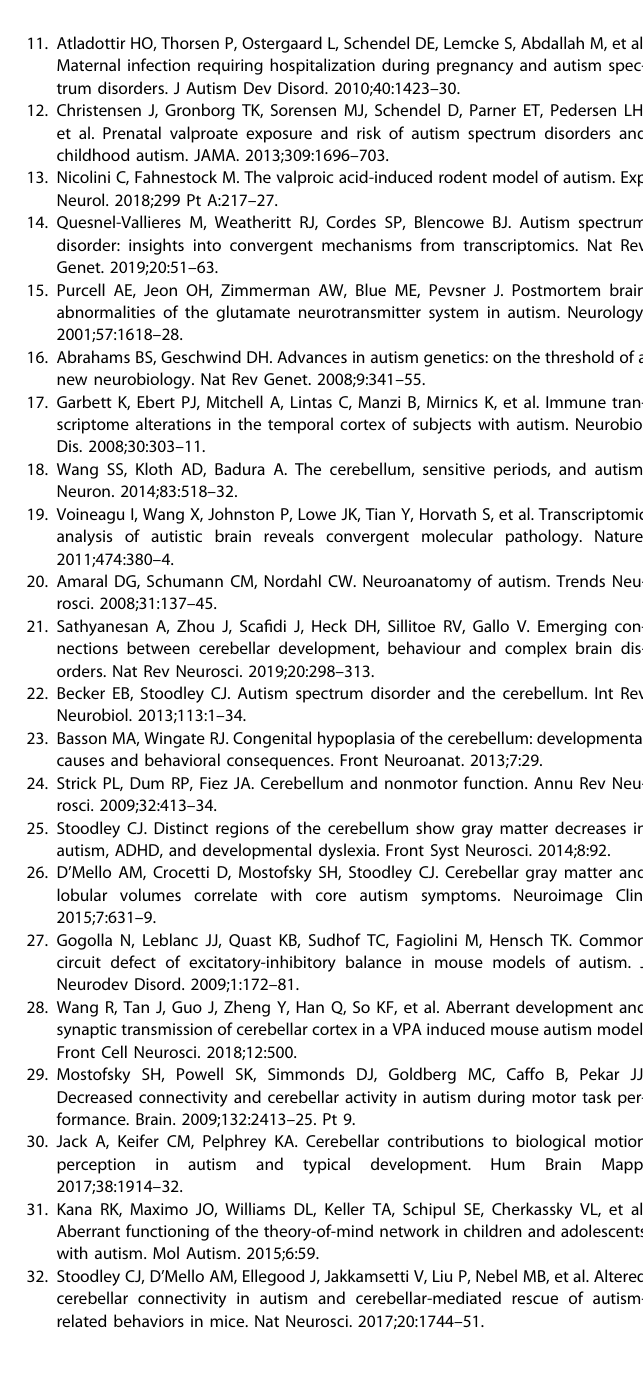
Fig. 5 SHANK3, SHANK2, ROR- α and GFAP proteins are downregulated in VPA mice at P10. Representative western blot images of the indicated proteins in Ctrl and VPA cerebella at P10 (left panel) and relative densitometric analysis (right panel). Data are expressed as: mean ± SD, * p value ≤ 0.05; ** p value ≤ 0.01; *** p value ≤ 0.001; **** p value ≤ 0.0001; number = not signi fi cant, test = unpaired t